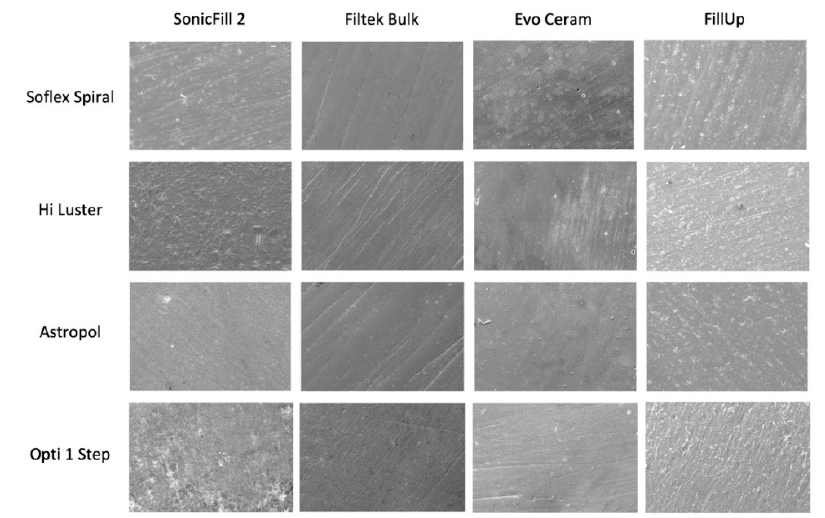
Figure 1. Scanning electron micrograph at 500× of the combinations of full-body bulk-fill and finishing systems tested.